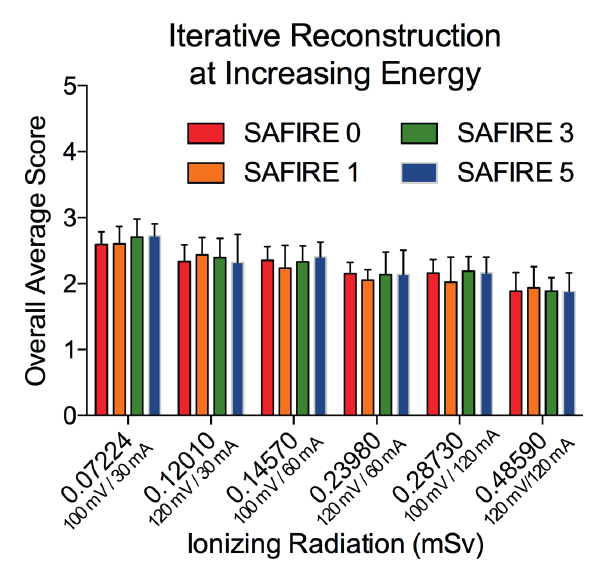
Figure 5. Iterative reconstruction did not improve the overall average score. Baseline scores without iterative reconstruction (red) are shown for all settings tested. IR setting of 1 (orange), 3 (green) and 5 (blue) did not improve the overall average